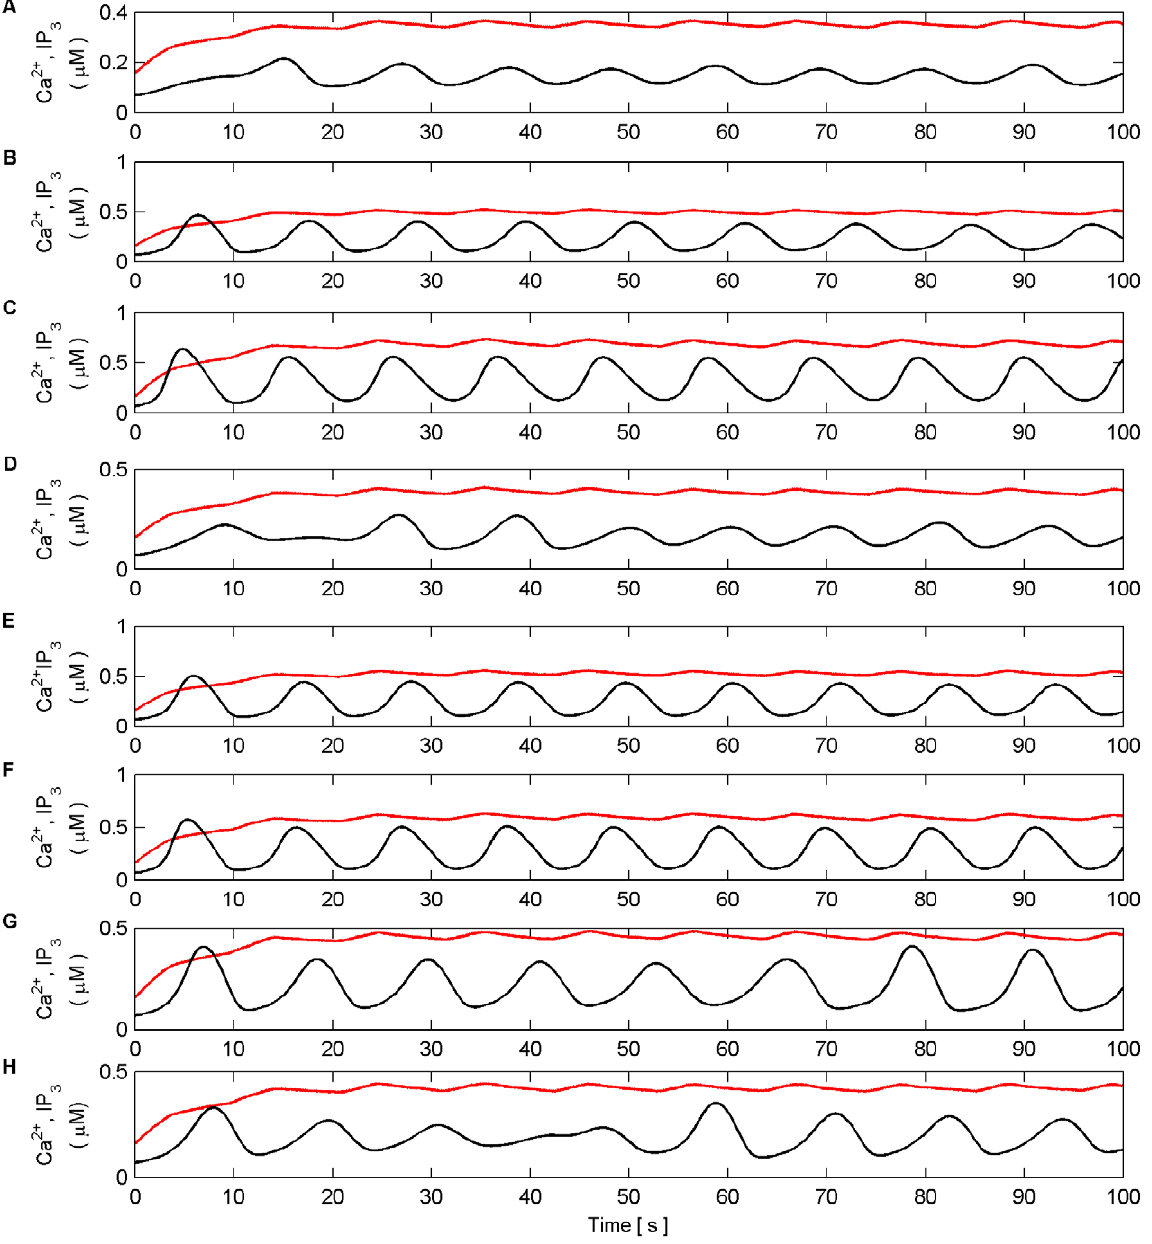
Figure 15. Individual Ca 2 + oscillations and IP 3 levels in AM mode. (A–H) Individual Ca 2 + oscillations (black), IP 3 transients (red) in each of the 8 microdomains associated with the synapses of N1 (A–D) and N2 (E–H). The input stimulus to each microdomain is a Poisson spike train with an average frequency of (A) 5 Hz, (B) 9 Hz, (C) 15 Hz, (D) 6 Hz, (E) 10 Hz, (F) 12 Hz, (G) 8 HZ, (H) 7 Hz. Note how the phase of the individual oscillations change, especially in (A), (D) and (H). Note also that the oscillation of IP 3 occurs at the same time for all microdomains. This is a result of the f function triggered by total Ca 2 + which regulates the release of neurotransmitter at all synapses. It is the global oscillation of IP 3 that causes the phase shift of the individual Ca 2 + oscillations.